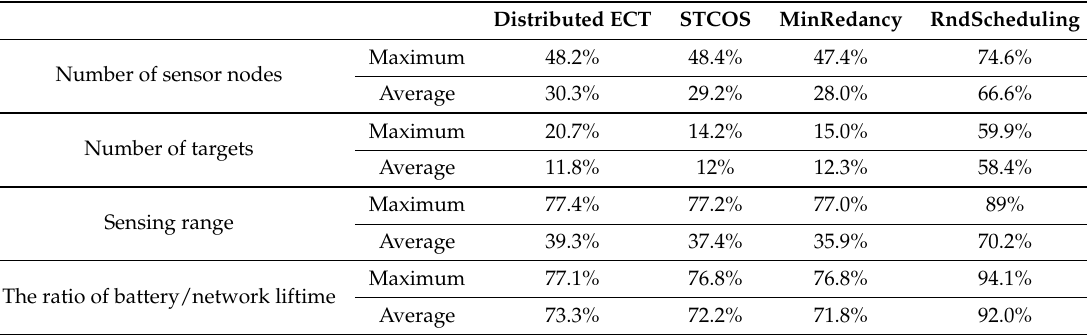
Table 1. Algorithm Comparison